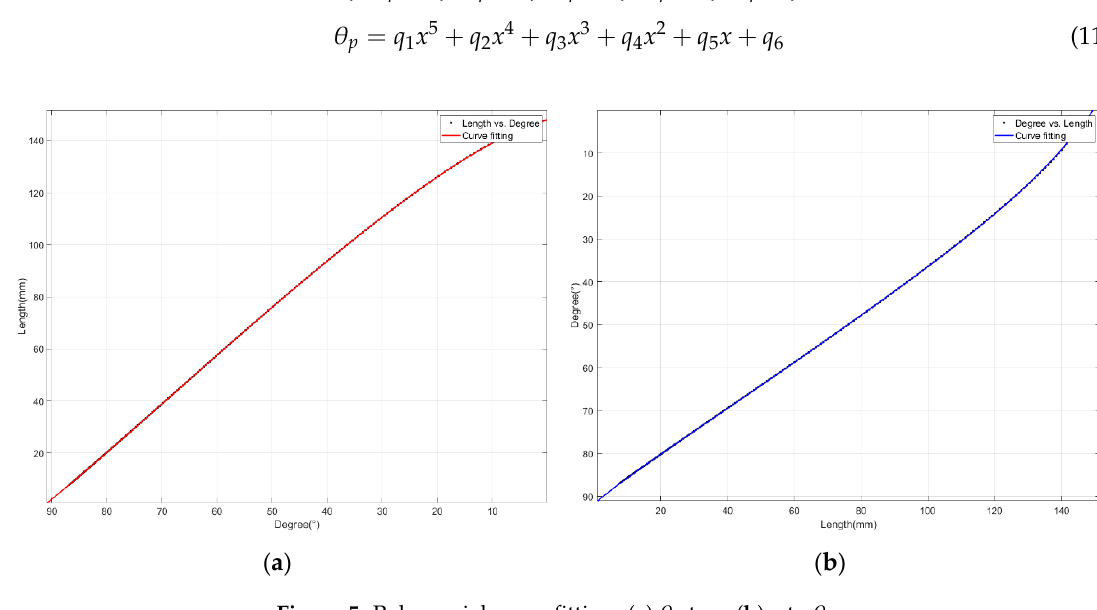
Figure 5. Polynomial curve fitting: ( a ) θ p to x ; ( b ) x to θ p . Table 1. Coe ffi cient of θ p and x